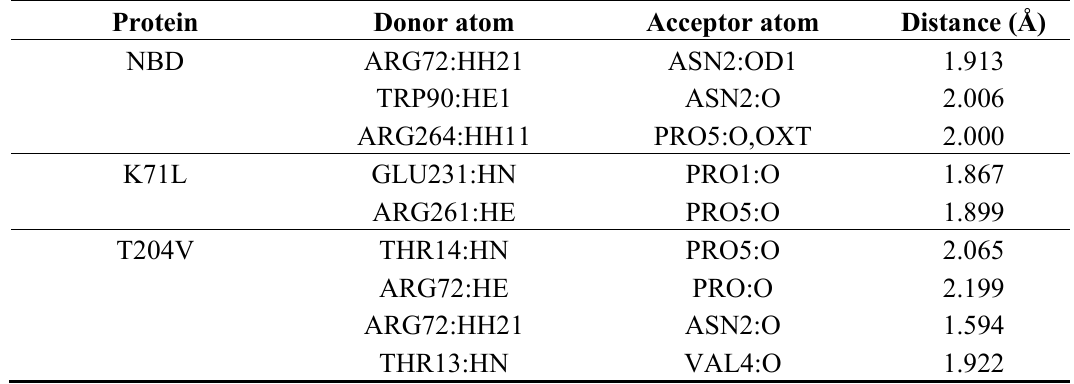
Table 6. Hydrogen bonds interaction studies of the NBD protein, K71L and T204V mutants with the E1A32 kDa motif.